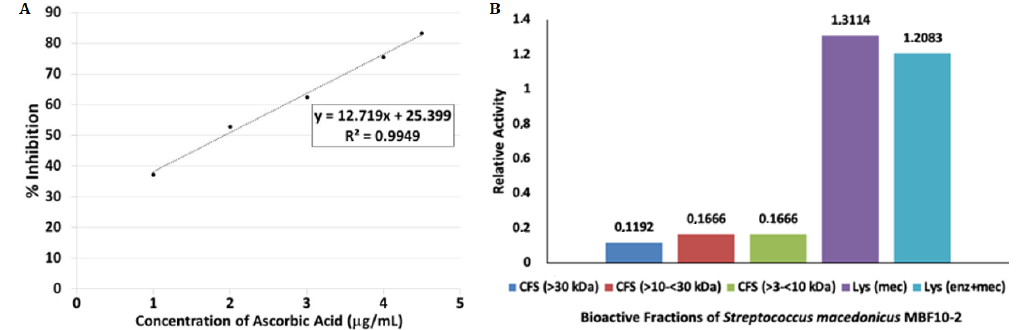
Figure 2. Antioxidant activity of Streptococcus macedonicus MBF10-2 fractions using DPPH. A) standard curve of reference standard of ascorbic acid; B) relative activity of Streptococcus macedonicus MBF10-2 fractions. Table II. Inhibition of DPPH for antioxidant assay of MBF10-2 fractions